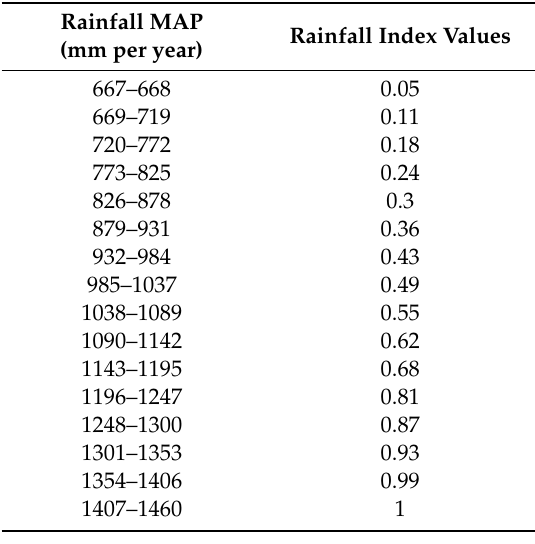
Table 1. Mean annual precipitation (MAP) in the Severn catchment classified in rainfall index values. The entire range (from maximum to minimum value of the temporal series) has been re-scaled from 0 to 1 (see text for